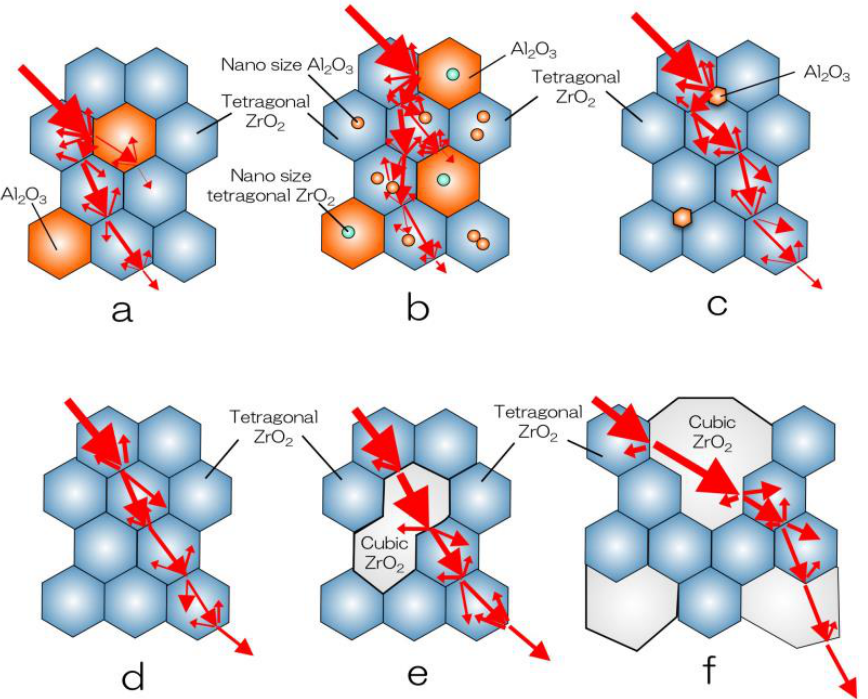
Figure 1. Schematic illustration of microstructure and light scattering of dental zirconia. ( a ) alumina- toughened zirconia (ATZ); ( b ) Ce-TZP/alumina nanocomposite (NanoZR); ( c ) conventional TZP (3Y-HA); ( d ) high translucent TZP (3Y); ( e ) high strength PSZ (4Y); and ( f ) high translucent PSZ (5Y).